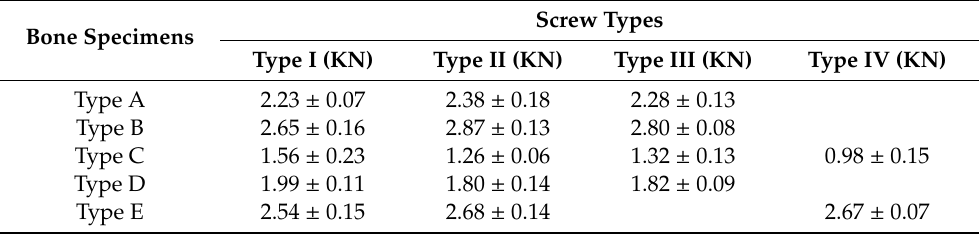
Table 2. Pullout strength of all types of screws in various bone